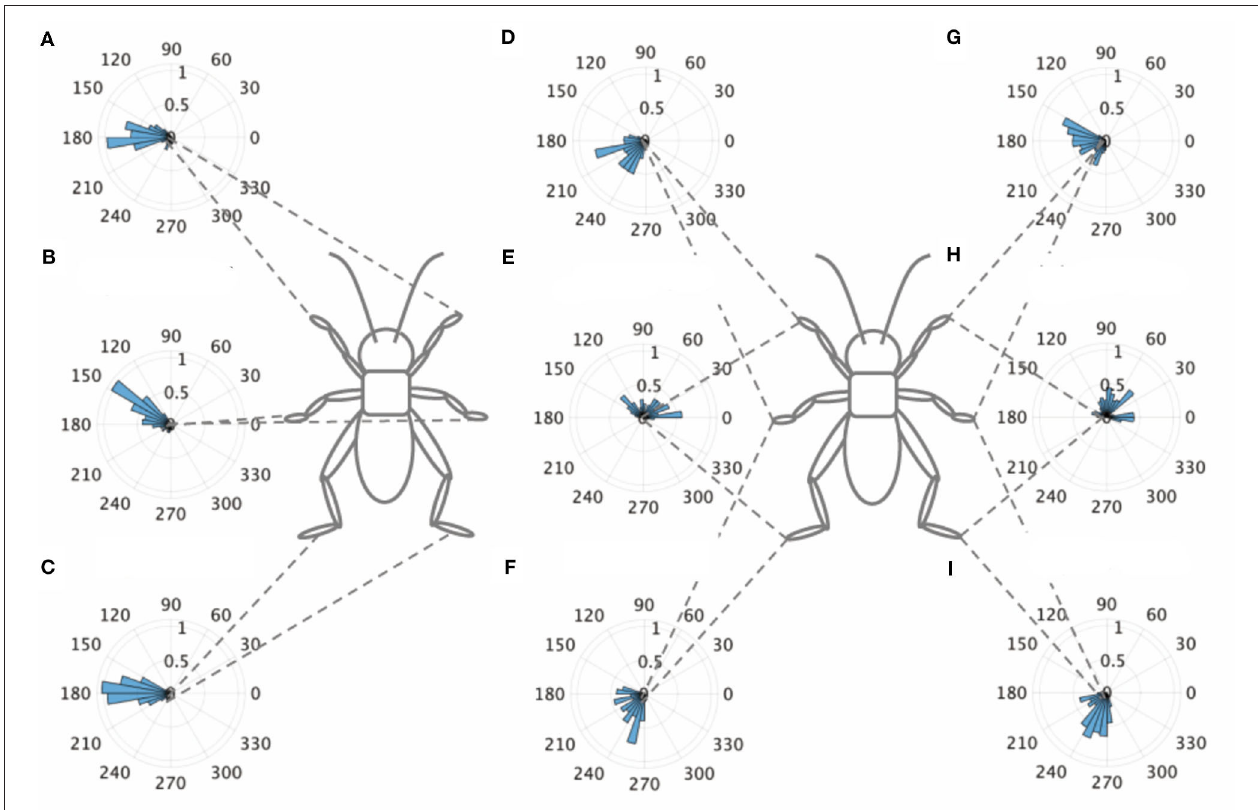
FIGURE 1 | Walking gait patterns of intact crickets. Polar histograms indicate the phase differences between two legs in the intact crickets ( N = 5), where the radial axis is the probability that the intact crickets exhibited a tripod gait pattern on the floating ball of the treadmill. (A) The phase difference between left and right forelegs. (B) The phase difference between left and right midlegs. (C) The phase difference between left and right hindlegs. (D) The phase difference between left foreleg and midleg. (E) The phase difference between left foreleg and hindleg. (F) The phase difference between left midleg and hindleg. (G) The phase difference between right foreleg and midleg. (H) The phase difference between right foreleg and hindleg. (I) The phase difference between left midleg and hindleg. LF, left foreleg; RF, right foreleg; LM, left midleg; RM, right midleg; LH, left hind leg; RH, right hind